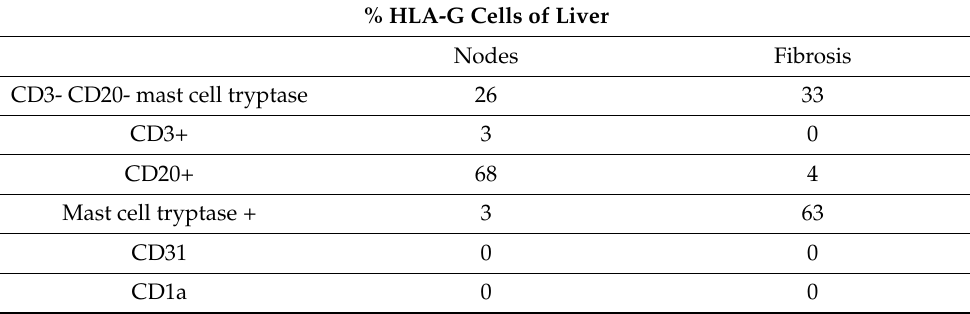
Table 3. Nature of HLA-G + cells according to the area of the liver in alcoholic cirrhosis (nodes and